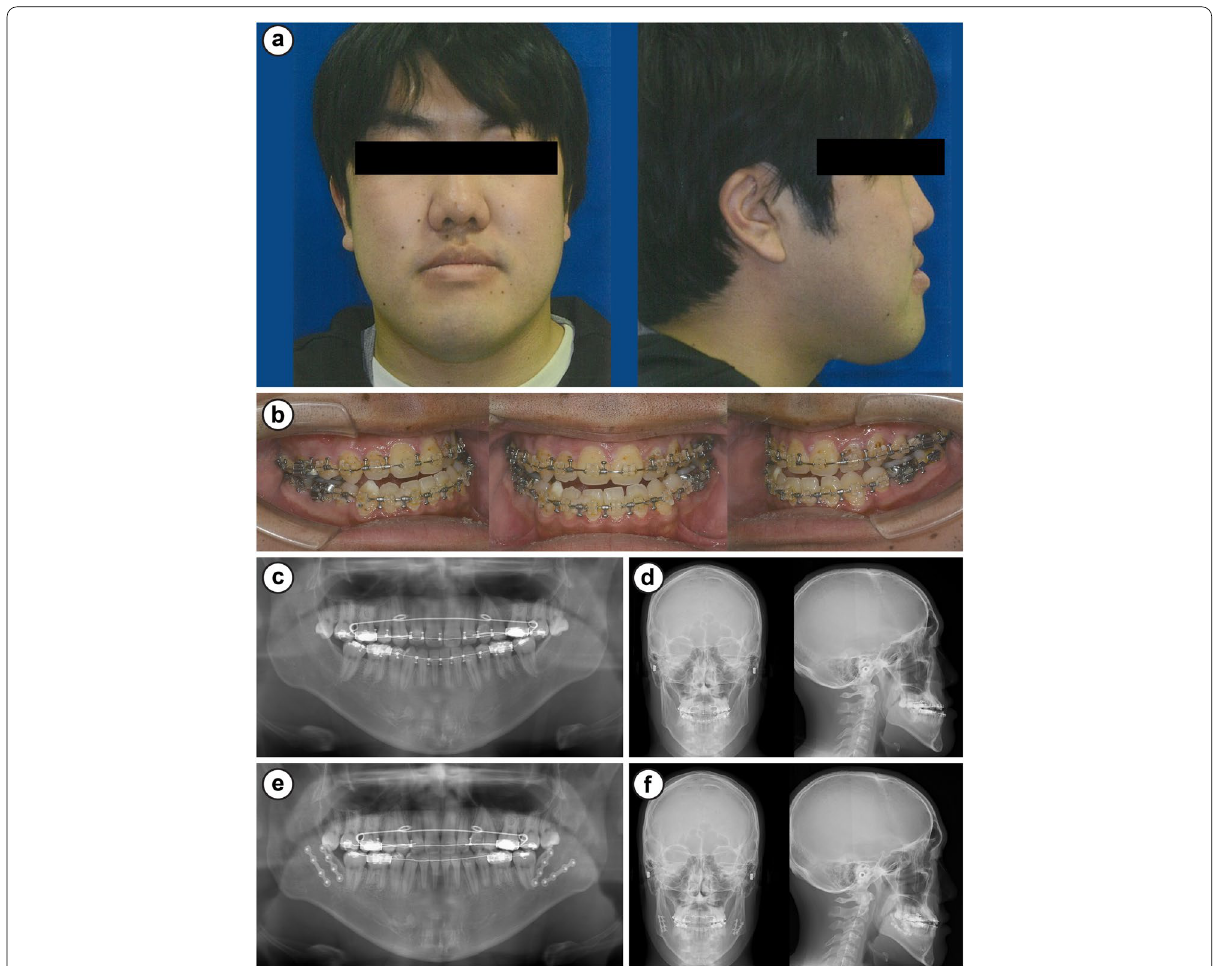
Fig. 1 Case 1. a Facial photographs, b intraoral images, c panoramic radiographs, d cephalometric radiogram, e panoramic radiographs 1 month postoperatively, and f cephalometric radiogram 1 month